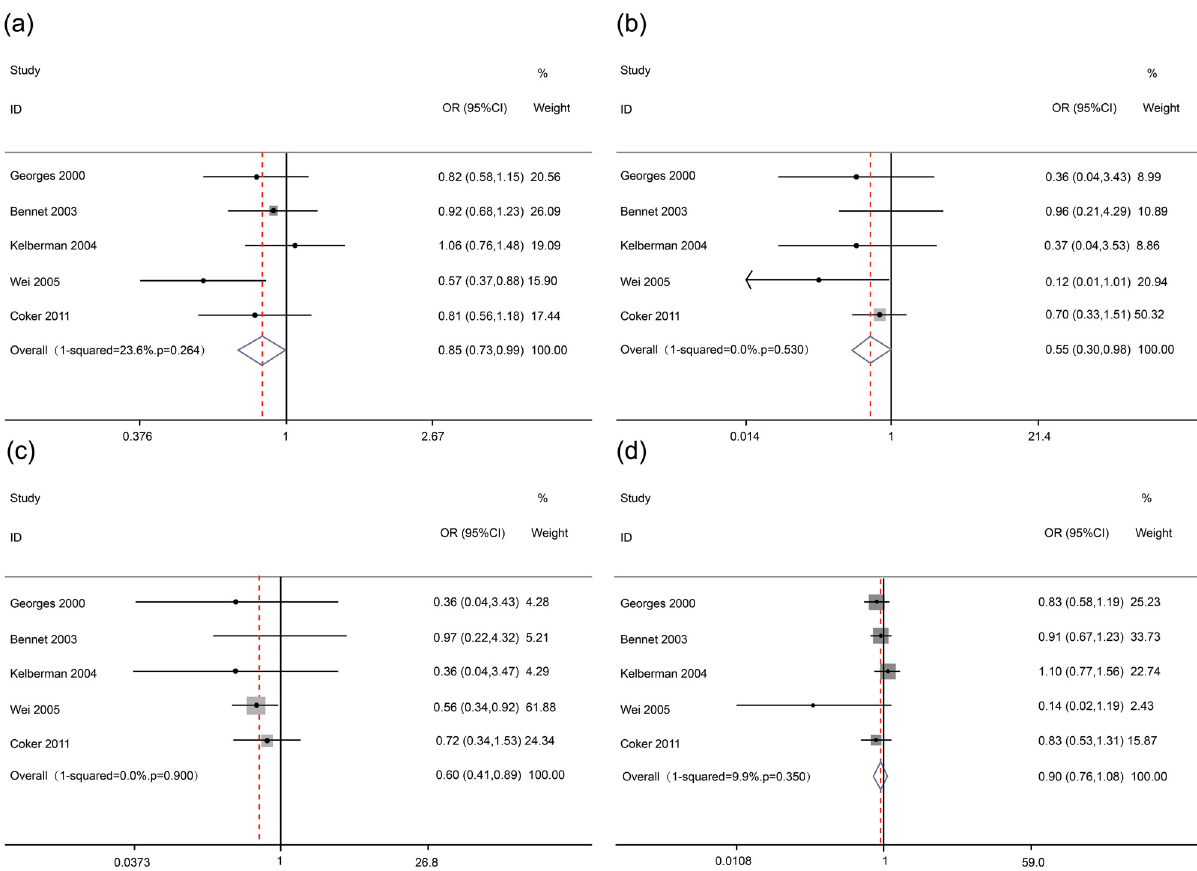
Figure 2: Forest plots for IL - 6 gene − 572 G > C polymorphism and MI in overall analysis. ( a ) ( allelic model: C allele vs G allele ) , ( b ) ( additive model: C/C vs G/G ) , ( c ) ( recessive model: C/C vs G/C + G/G ) and ( d ) ( dominant model: C/C + G/C vs G/G )